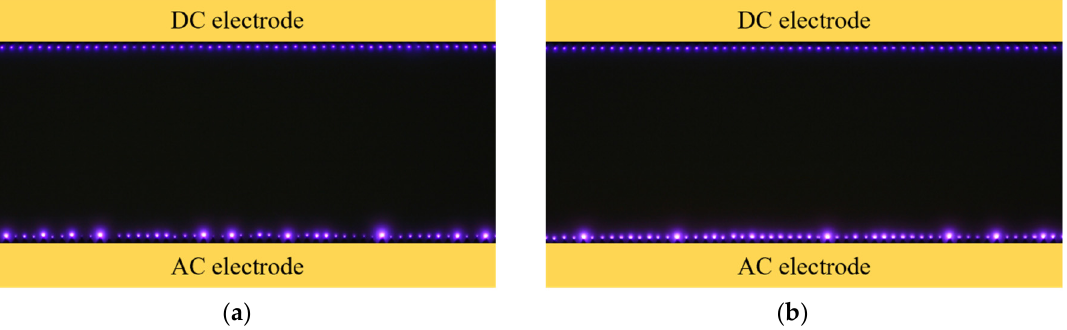
Figure 10. Discharge photographs in the case where the AC electrode was grounded and a voltage of 14 kV was applied to the DC electrode in the ( a ) CD-PA and ( b ) TED-PA.